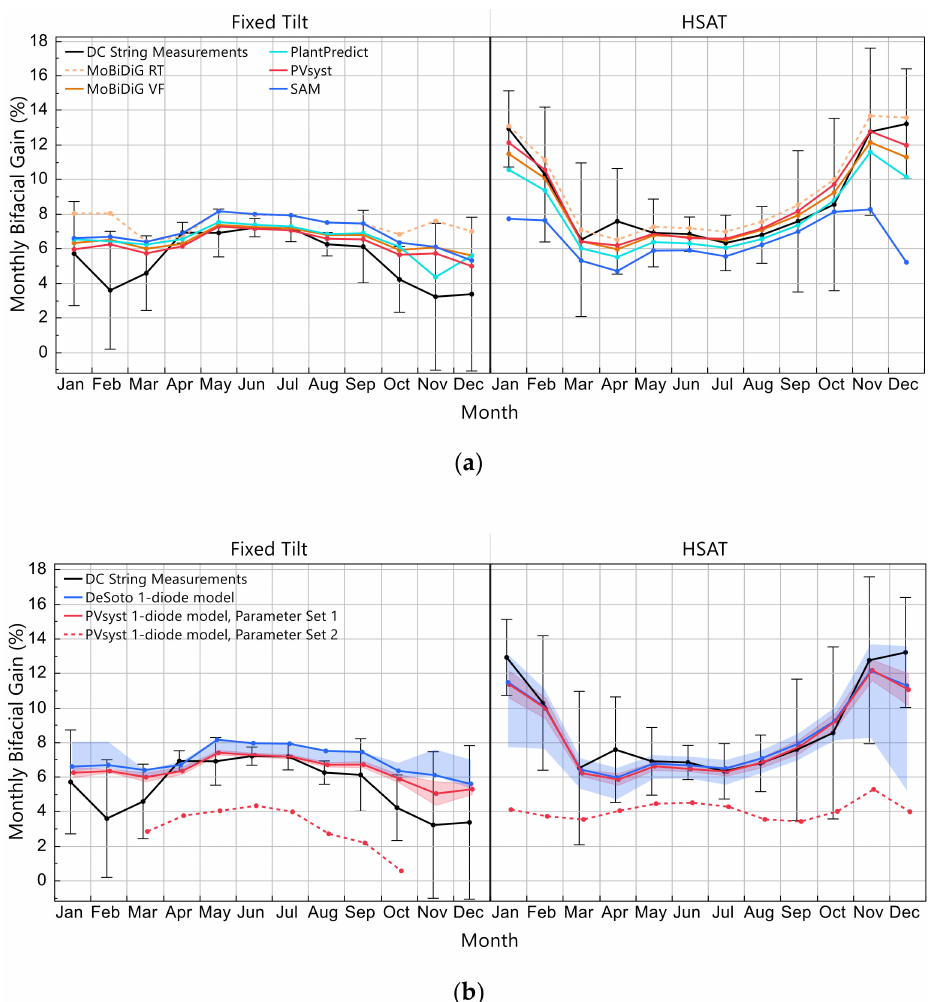
Figure 11. Monthly bifacial gain on fixed-tilt and HSAT systems calculated with Equation (1). All plots show bifacial gain as simulated by five software and from DC string measurements. The black error bars show the inner quartile range of daily bifacial gain measurements within each month. Datapoints when sun elevation is lower than 5 ◦ above the horizon are not included in these plots. ( a ) Results grouped by software (Table 1). ( b ) Results grouped by which 1-diode model and parameter set was used. PVsyst Parameter Set 1 is based on laboratory I-V measurements at multiple irradiances while PVsyst Parameter Set 2 is based on only STC